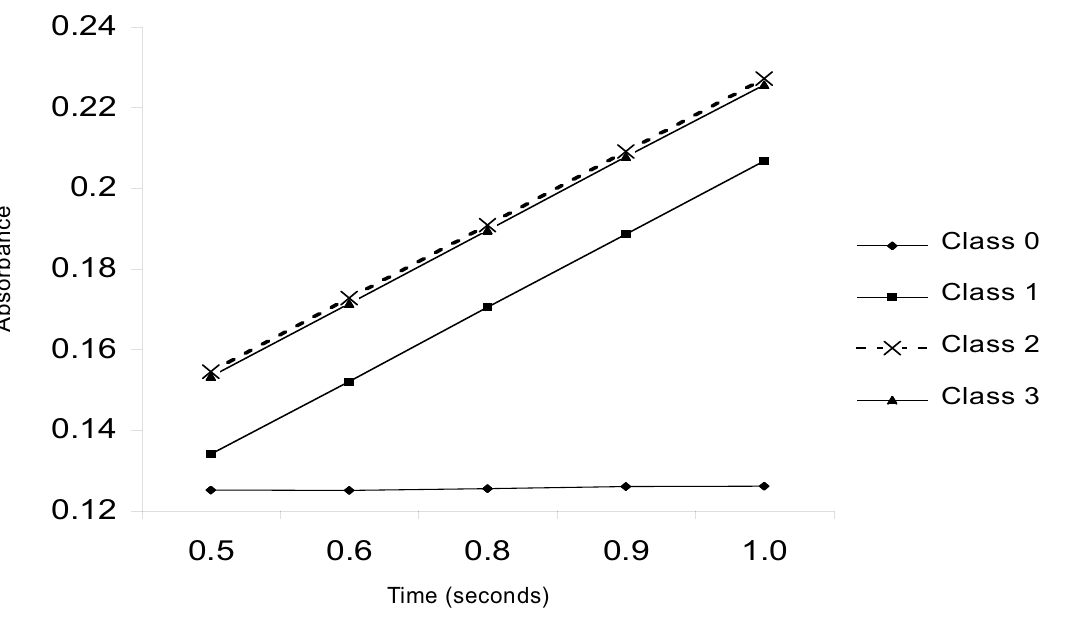
Fig. 2. Peroxidase activity expressed as absorbance in leaves of apricot with no symptom and with different symp- tom class (0